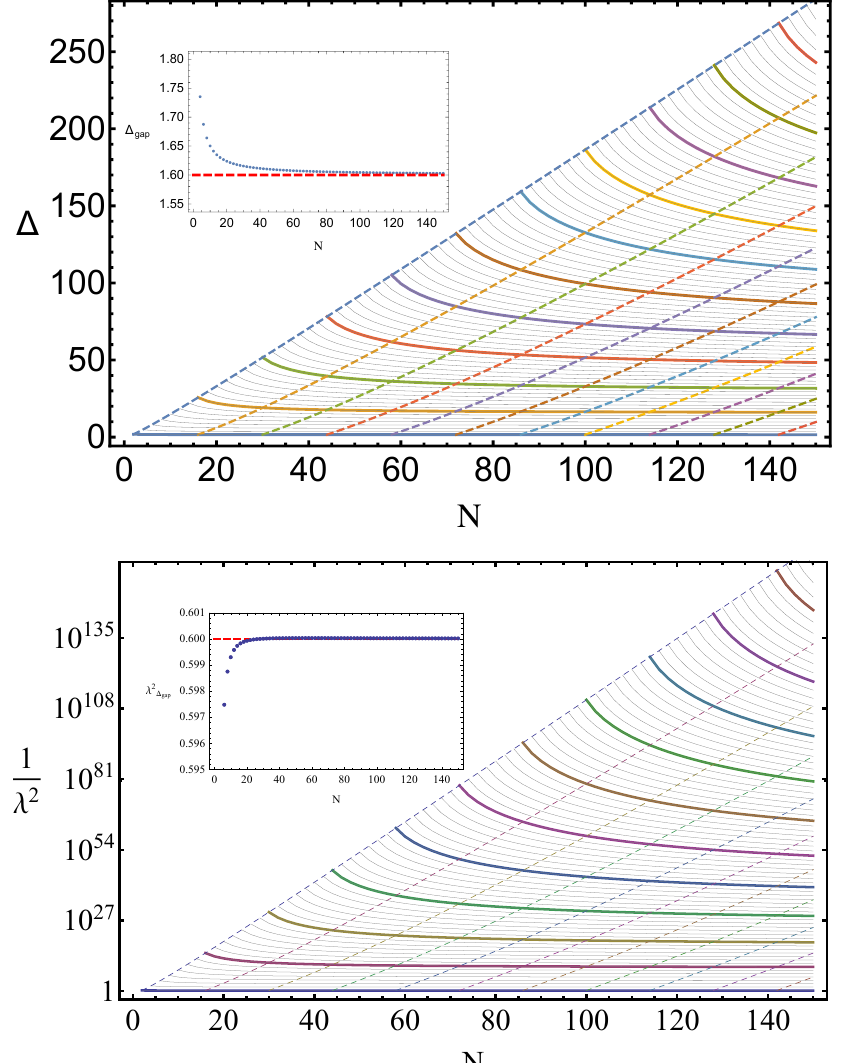
Figure 3 . Upgrading. Plots show the evolution of the spectrum as the number of crossing con- straints N is increased. At the top the conformal dimensions, and on the bottom the corresponding OPE coe(cid:14)cients. For each N , cutting the curves with a vertical line gives the spectrum at that N . For clarity a few chosen curves are highlighted in color. As N increases new operators appear. Their dimension and OPE coe(cid:14)cient vary a lot in the beginning, but eventually stabilize. The diagonal dashed lines interpolate the successively largest dimension operators, and their OPE coe(cid:14)cients, as a function of N . The insets show the leading operator. Notice in particular the leading OPE coe(cid:14)cient converges very fast. Finally, for any N the value (cid:1) is a valid upper bound, which gap explains it’s decrease with N